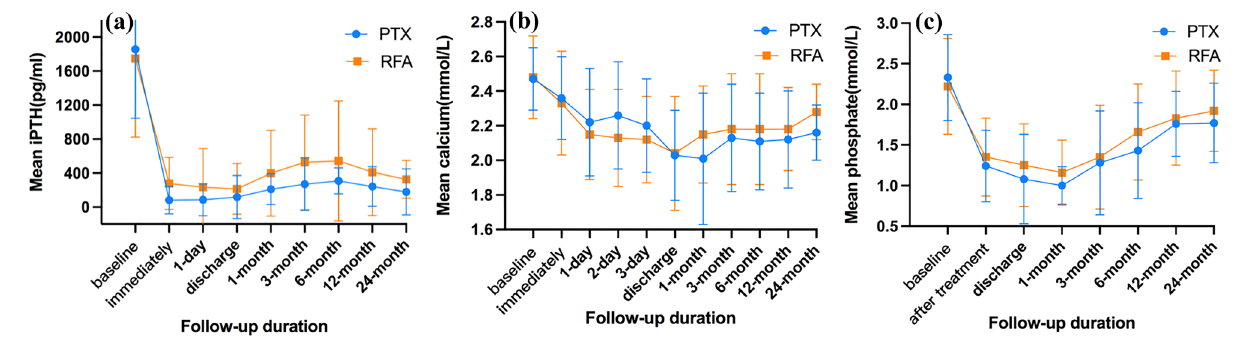
Figure 3. Mean iPTH concentrations ( a ), calcium ( b ), and phosphate ( c ) concentrations in patients treated with parathyroidectomy or ultrasound-guided radiofrequency ablation during the study period. iPTH intact parathyroid